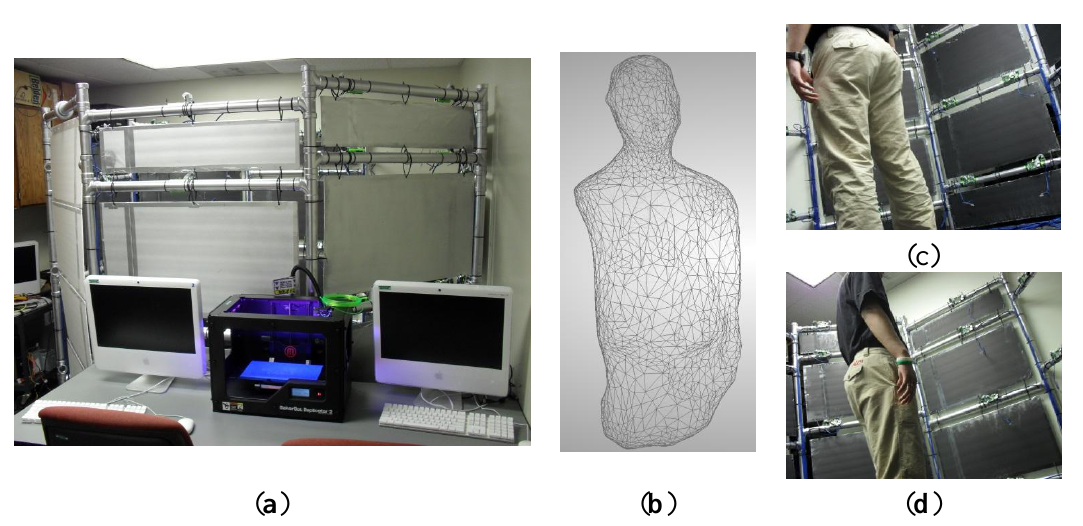
Figure 9. ( a ) 3D Scanner in final location with console stations and 3D